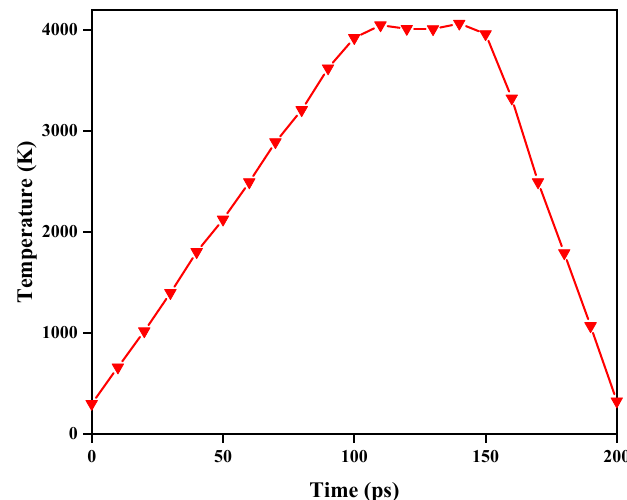
Figure 2. Temperature variation during annealing in the cloaking region.